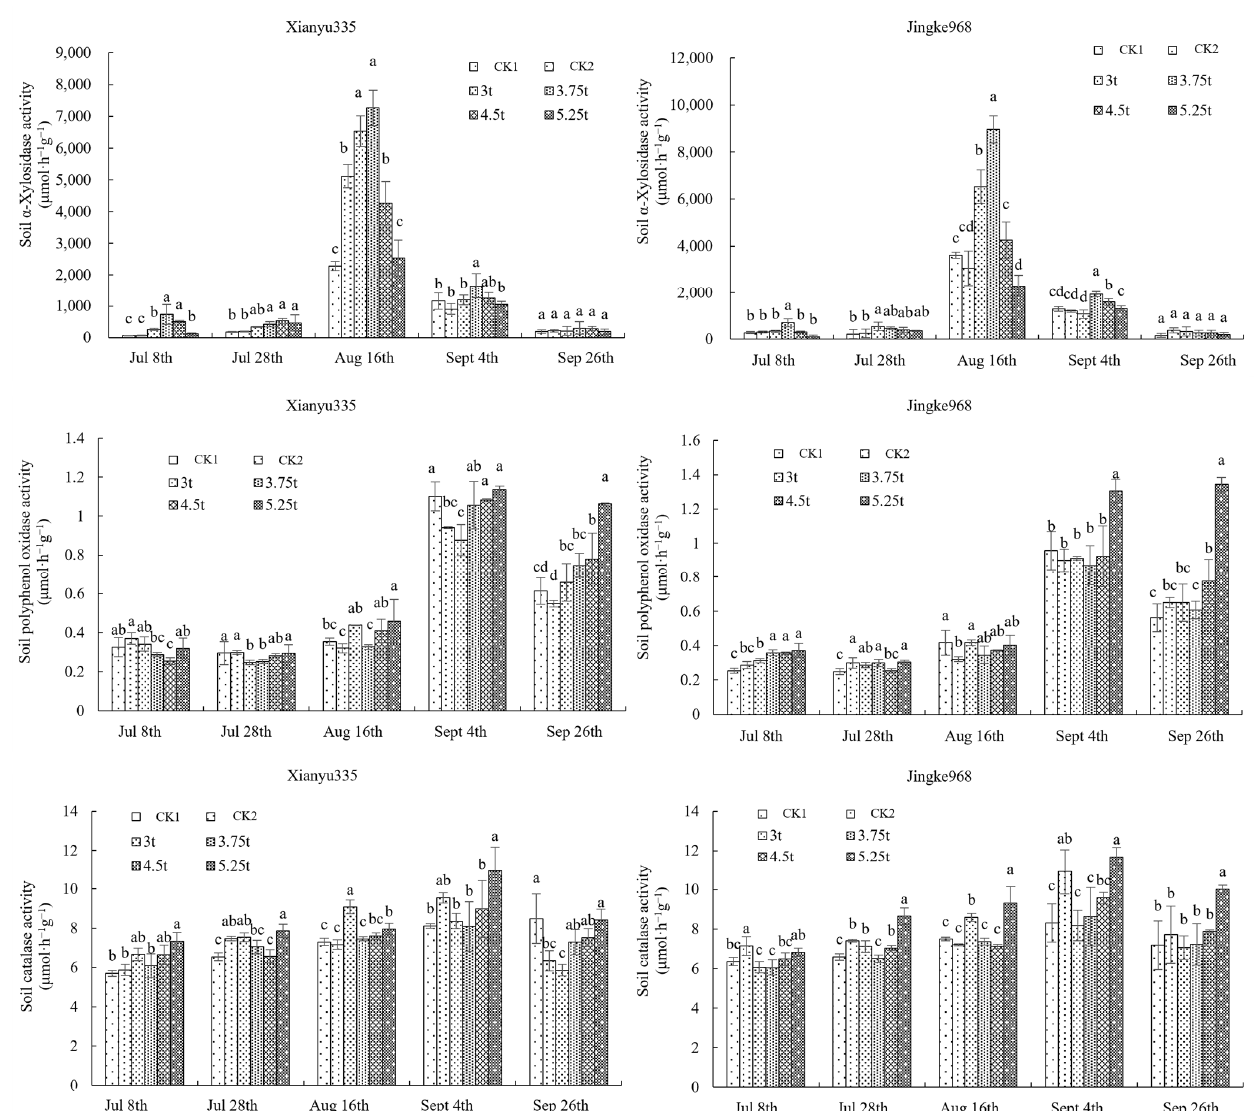
Figure 4. Effect of carbon-based fertilizer on soil α -Xylosidase activity, soil polyphenol oxidase activity, and soil catalase activity. Notes: Different letters within the same column indicate significant difference at the 5% level.